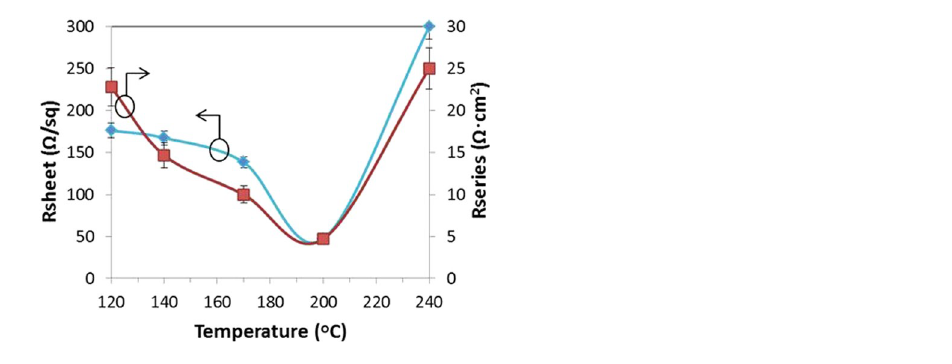
The extracted PCE for the NWSCs with the composite top electrode was 5.7 ± 1.2%, an enhancement of ~60% compared to the AZO-only contacts (PCE = 3.9 ± 1%). This improvement was due to several factors. First, the composite electrode has a reduced R series and an increased shunt resistance (R shunt ) (Table 1). Secondly, the increased conformal coverage of the electrodes by the Ag NWs improved charge collection resulting in higher J SC and FF values (Fig. 5). Furthermore, the increased light scattering between disorderd NWSCs enhanced absorp- tion and increased J SC compared to the planar structure. The AZO/Ag NW composite layer alone, without the NWSC, was also assessed on flexible polyethylene napthalate (PEN) substrates to determine the effect of mechanical strain on the electrical properties of the con- tact. R sheet of the different electrodes was measured (Fig. 6) under bending of the PEN to various radii of curva- ture, R , from 38 mm to 4 mm in both concave-up ( i . e . bending of the flexible substrate upwards to the incoming light) and concave-down ( i . e . bending downward from the incoming light) orientations to produce compressive and tensile strain states in the film, respectively. SEM micrographs of the planar AZO thin-film under tension